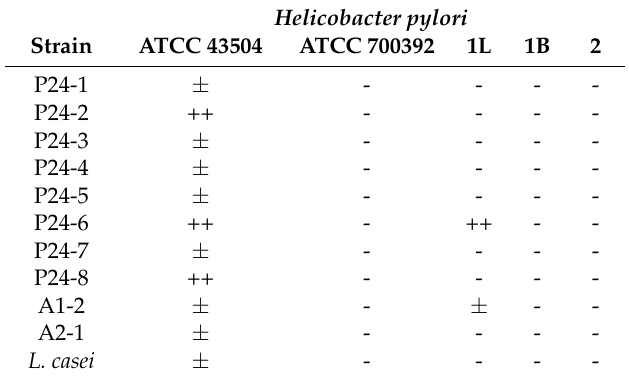
Table 3. Antibacterial activity of isolated LAB against Helicobacter pylori